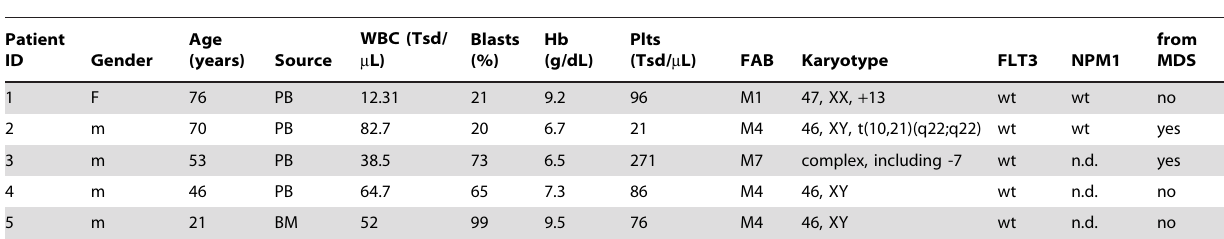
Table 1. AML patient